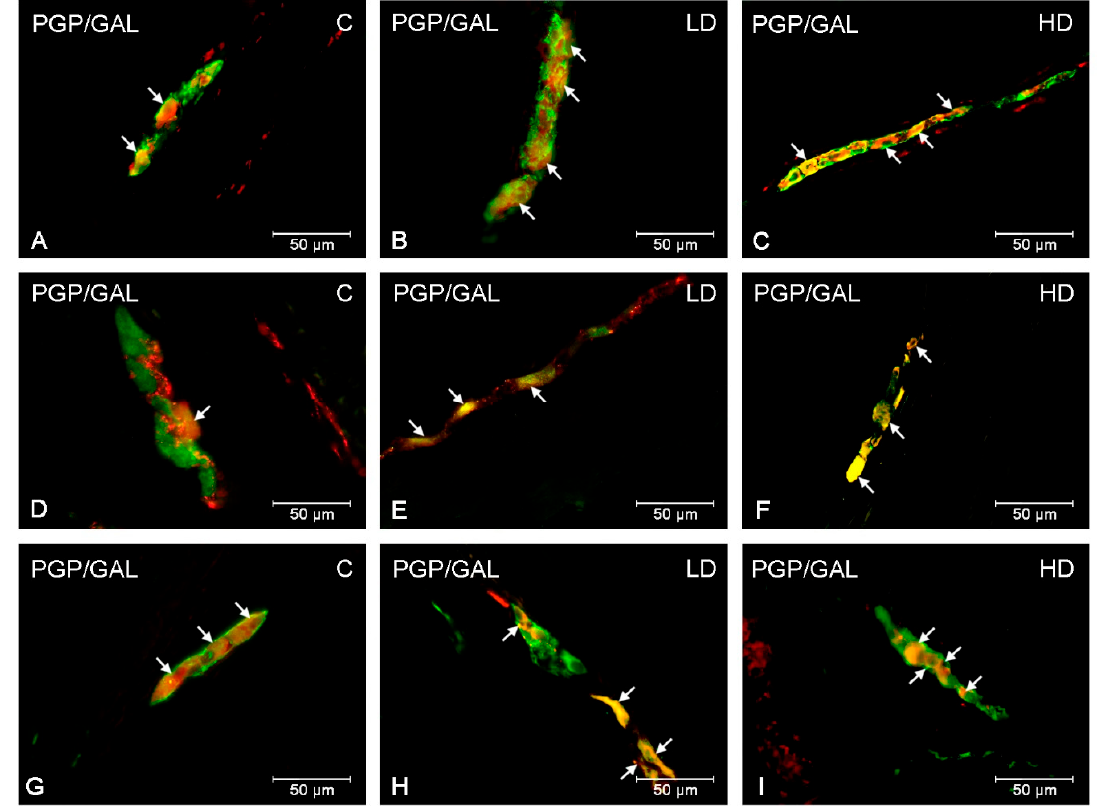
Figure 2. GAL-LI neurons in submucous plexuses in the porcine stomach. The ENS neurons immunoreactive to protein gene-product 9.5 (PGP9.5)—used as a pan-neuronal marker and galanin (GAL) in submucous plexuses in the porcine stomach under physiological condition ( A , D , G ), after low ( B , E , H ) and high doses ( C , F , I ) of acrylamide supplementation. Photographs A–C showing submucous plexuses in the cardia, D–F— submucous plexuses in the corpus and G–I— submucous plexuses in the pylorus. All photographs have been created by digital superimposition of two colour channels (green for PGP 9.5 and red for GAL). Neurons immunoreactive to GAL are indicated with arrows.